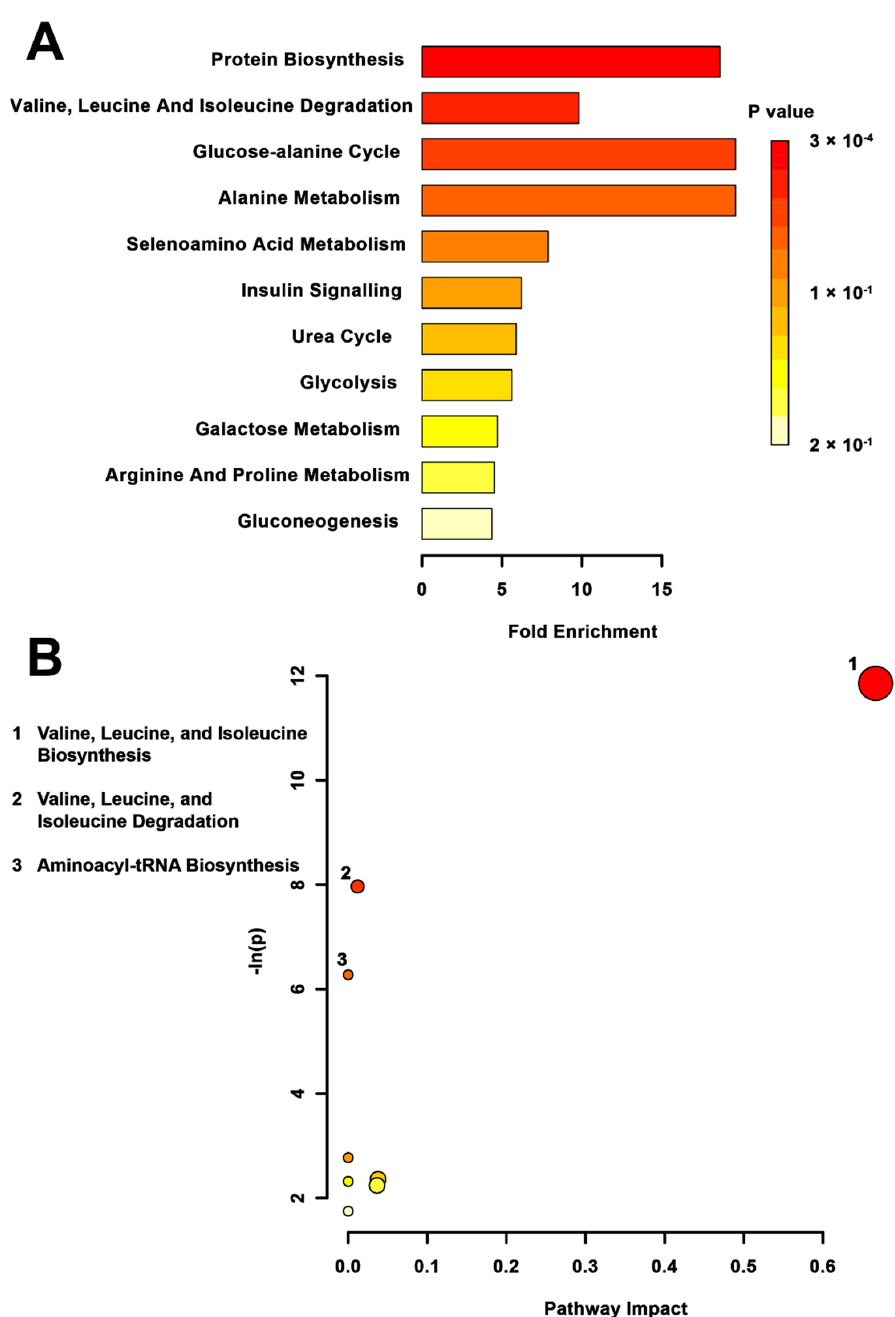
Figure 2. Pathway-associated metabolite set enrichment analysis (MSEA) for TPS vs. CONT. ( A ) Plot showing affected biological processes in transgenerationally stressed (TPS) compared to non- stressed (CONT) rats based on metabolites identified as significantly altered between these groups. The p -value for each pathway is shown using the heatmap on the right of the figure and the fold enrichment shows how many times greater than chance the process is involved. ( B ) Metabolomic pathway analysis showing all matched pathways according to p -values from pathway enrichment analysis and pathway impact values from pathway topology analysis in TPS and non-stressed CONT rats. The y-axis shows the negative natural log of p , such that a higher value on the y-axis gives a lower p -value. The x-axis gives the pathway impact, which correlates to the number of metabolite hits in a particular pathway. Only metabolic pathways with p < 0.05 are labeled. TPS had the highest impact on valine, leucin, and isoleucine biosynthesis.